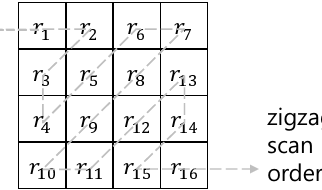
Figure 2. The representation of 4x4 QDCT